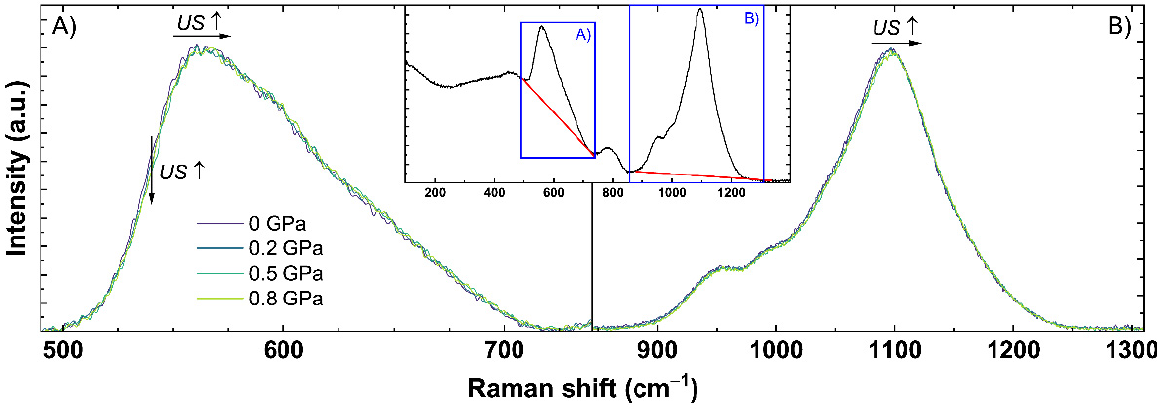
Figure A2. Detailed analysis of the obtained Raman spectra for ( A ) the range of the main band and ( B ) the Q-range. An example of the complete untreated Raman spectrum is shown in the inset. The red line displays the used baseline correction for each range indicated by the blue boxes. Effects of applied uniaxial stress ( US ↑ ) are indicated by the shown arrows: horizontal for shifts and vertical for intensity changes in the corresponding direction of the displayed arrow. Table A1. Experimental data and spectroscopic observables of the q g 1 sample used for the multiple linear regression model.